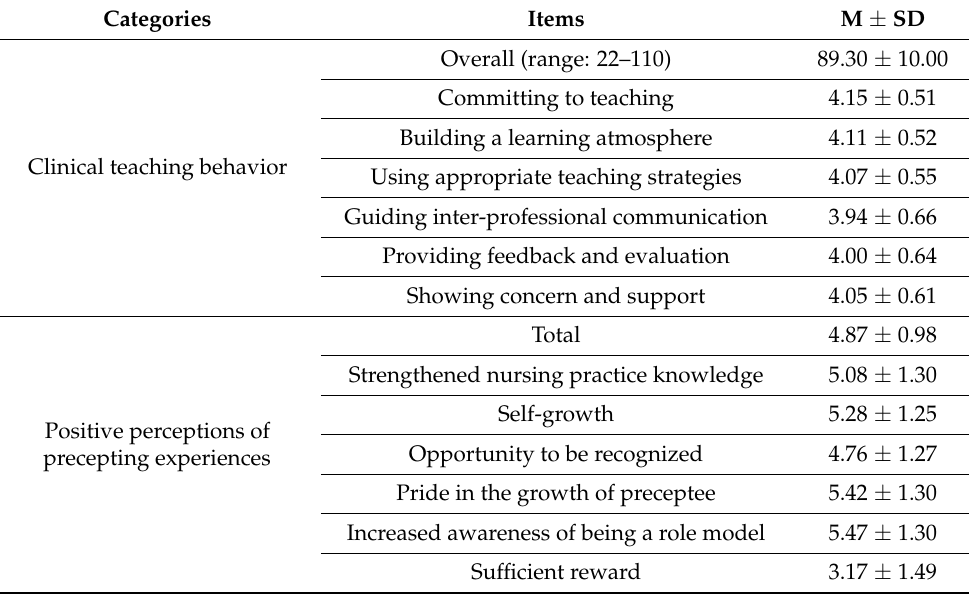
Table 3. Clinical teaching behavior and positive perceptions of precepting experiences ( n = 180).